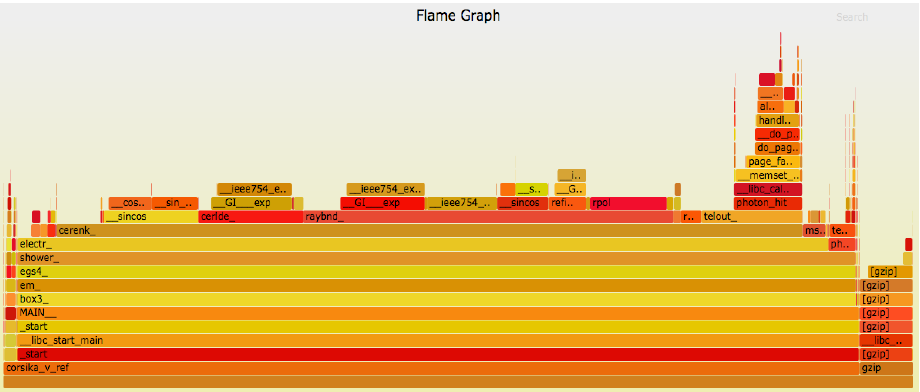
Figure 1. Corsika profile produced with Linux perf and the FlameGraph